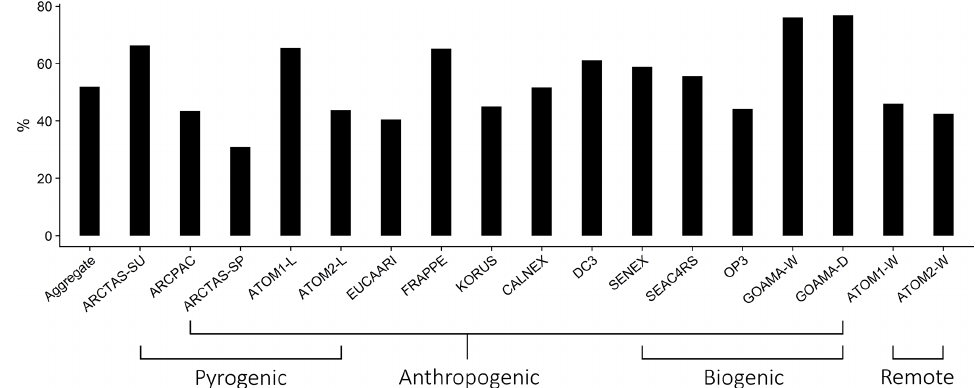
Figure 3. The percentage contribution of organic aerosol by mass to the total observed non-refractory mass concentrations measured by the AMS; organized by campaign. This includes aerosol mass from organic aerosol, sulfate, nitrate and ammonium. Campaigns are broadly organized based largely on model-characterized source influence. However, as noted in the text, this characterization is often not indicative of the true sampling profile. For instance, the GoAmazon campaigns sampled heavily from fire and anthropogenic sources in addition to being strongly influenced by biogenic sources.